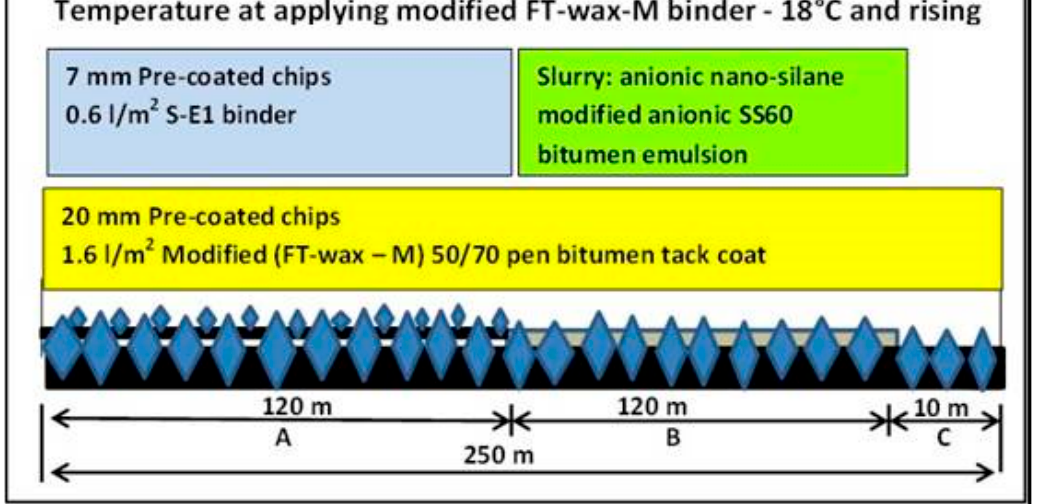
Figure 2. Experimental layout of three different chip and Cape seal surfacings constructed for Accelerated Pavement Testing (APT) and evaluation.